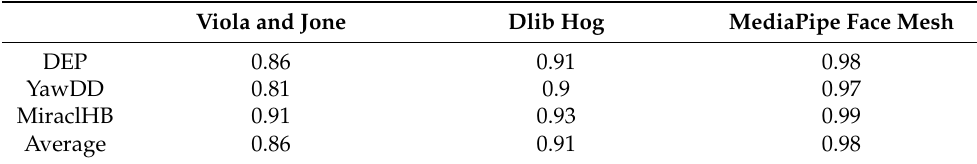
Table 1. F-measure for face detection experiments using MiraclHB, YawDD, and DEAP databases. Viola and Jone Dlib